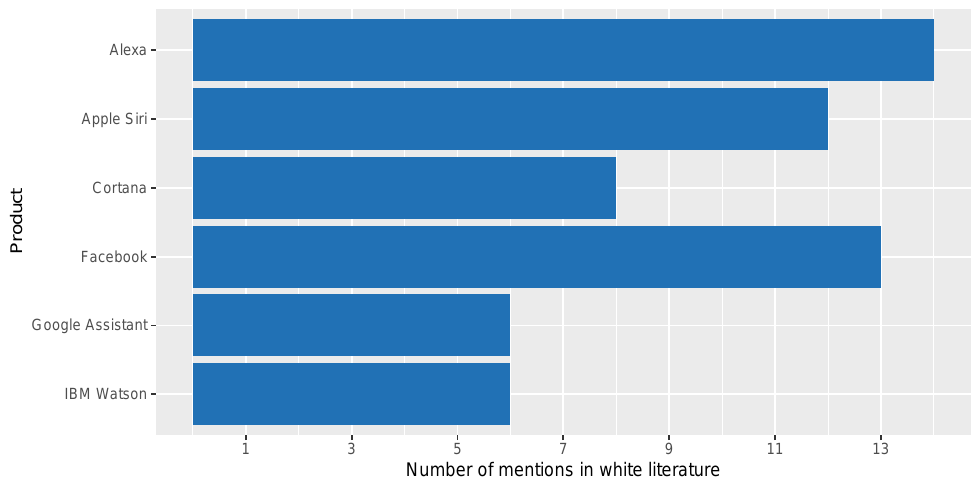
Figure 13. Number of mentions for industrial products in selected white literature sources.